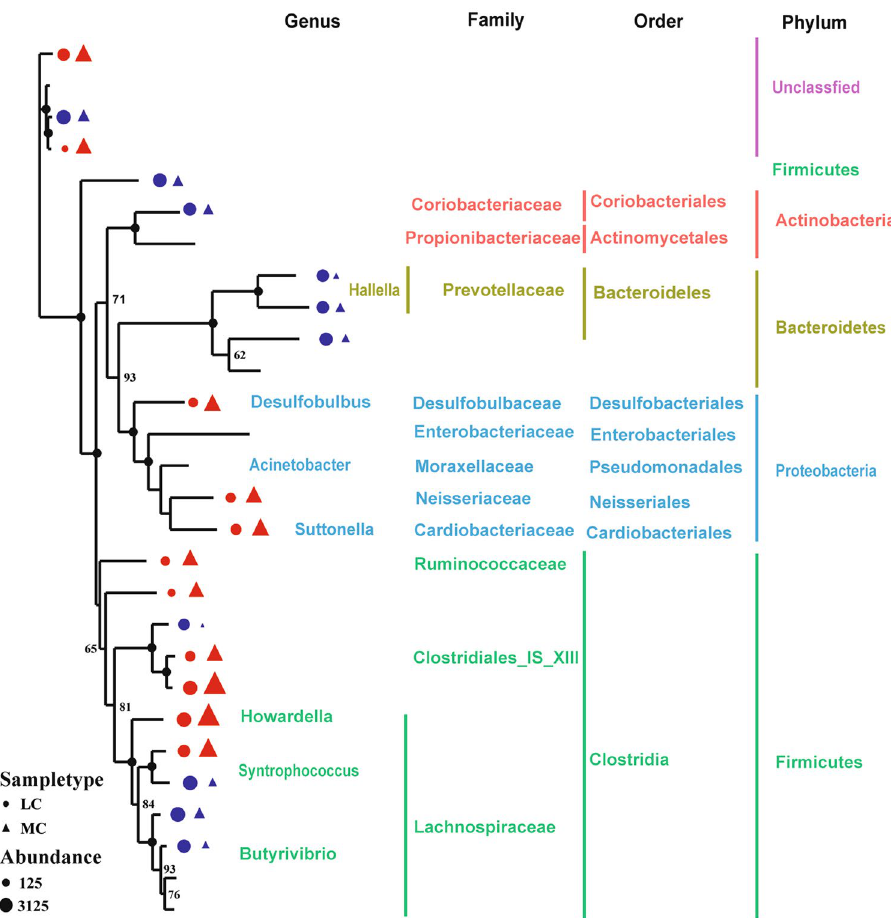
Figure 2. Maximum likelihood tree of 28 detectable OTUs (the relative abundance > 1% in the given sample). The complete 16S rRNA gene sequences of the corresponding species in the RDP database were used to construct the tree. The triangle indicates the OTUs in the MC group, and the circle indicates the OTUs in the LC group. Only the OTUs with significantly different ( p < 0.05) relative abundances are shown behind the branches. The size of the symbol indicates the relative abundance of the OTUs. Red indicates a significant expansion ( p < 0.05) of the relative abundance of the OTU under the 35% concentrate diet and blue indicates a significant reduction ( p < 0.05) in the relative abundance of the OTU under a 10% concentrate diet. Only those bootstrap values greater than 60 are shown on the tree. The solid black circles at the nodes stand for a bootstrap value of